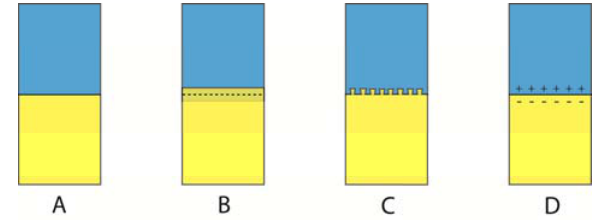
Figure 10. Of these four adhesion mechanisms, ( A ) represents contact adhesion, in which molecules interact (physical, acid-base or covalent), ( B ) diffusion induced interface adhesion, ( C ) mechanical interlocking, and ( D ) electrostatic interaction across the interface. Adhesion in general tend to use a combination of these four